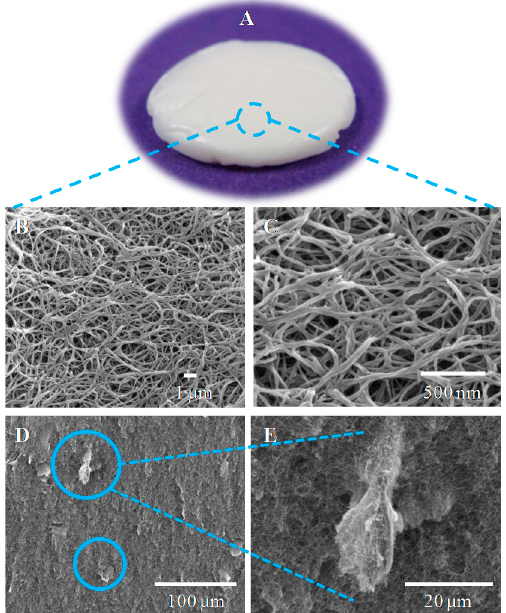
Figure 5. Microscopy images of NA: ( A ) optical image, ( B ) SEM image at 10,000× with 1 μ m scale, ( C ) FE-SEM image at 80,000× with a 500-nm scale, ( D ) SEM image at 1000× with a 100- μ m scale, ( E ) SEM image at 5000× with a 20- μ m scale. The blue circles in (D) indicate undissolved fiber residues as magnified in (E).